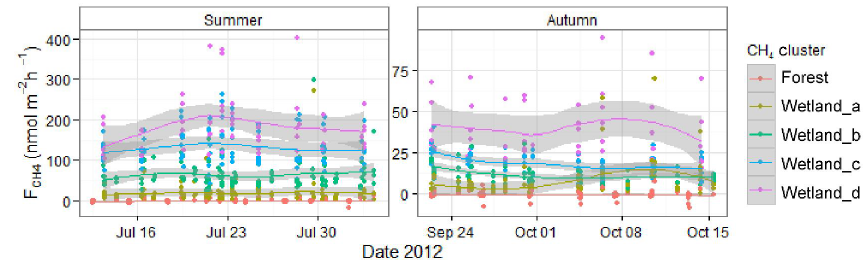
Figure 8. Temporal variability across the two field campaigns in CH 4 emissions, separated by clusters, with shaded area representing loess smoothing. Clusters Wetland_a to Wetland_d represent groups with sequentially increasing CH 4 emissions.